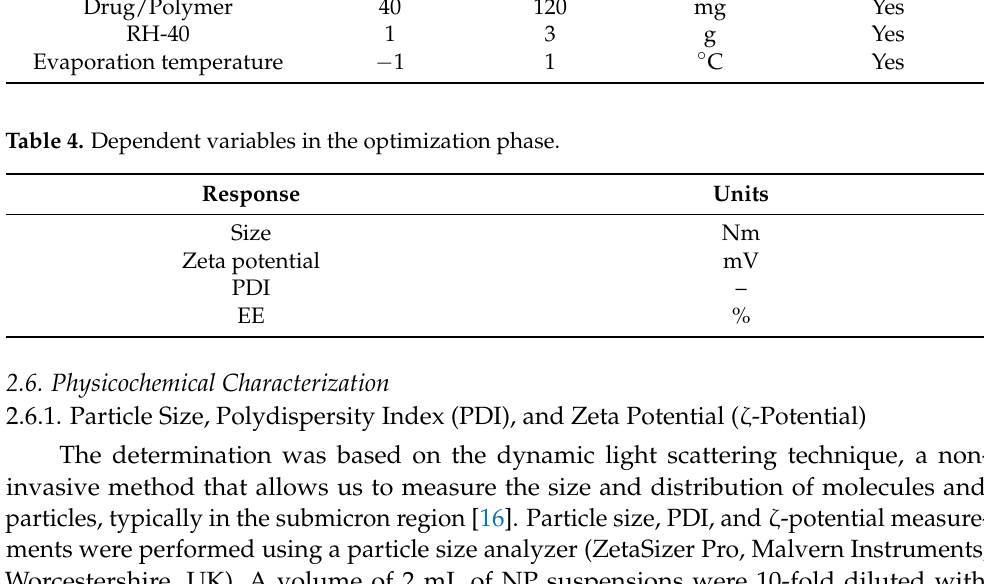
× 100 Figure 2. Encapsulation efficiency equation. The method was validated using the validation guide for analytical methods pub- lished by the National College of Pharmaceutical Chemists and Biologist A.C [17]. 2.7. In Vivo Model An animal model for biomedical research is one in which normative biology or be- havior can be studied, or in which a spontaneous or inducing pathological process can be